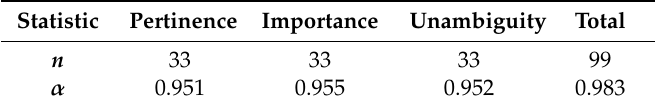
Table 8. Internal consistency of the items that make up the IMLPFoot.